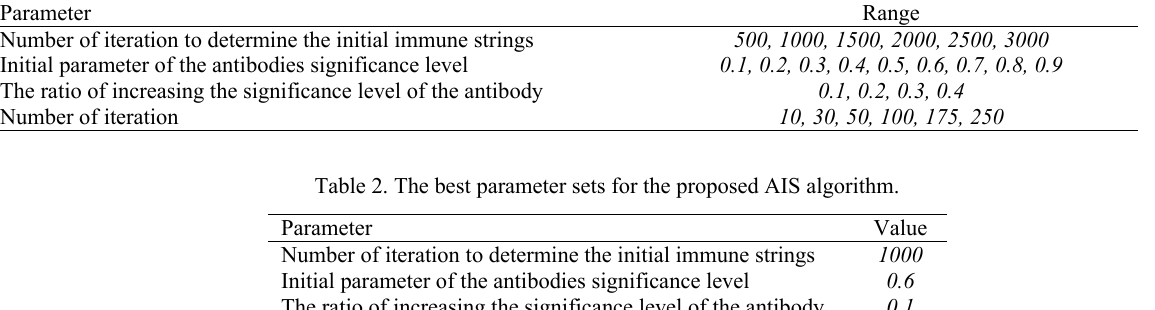
Table 1. Parameters of the proposed AIS for multiobjective fuzzy flow shop scheduling. Parameter Range Number of iteration to determine the initial immune strings